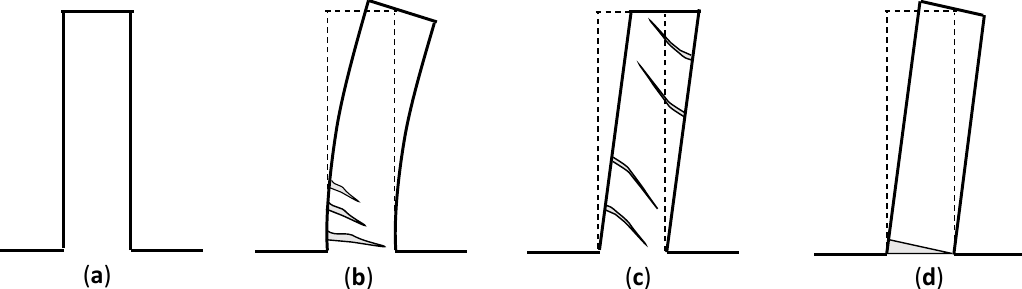
Figure 1. Idealized components of horizontal displacement: ( a ) Original undeformed configuration as a cantilever column; ( b ) bending deformation; ( c ) shear deformation and ( d ) bonding deformation. Flexure is by far the most relevant aspect in determining the seismic response of a bridge pier and it is also the most investigated.